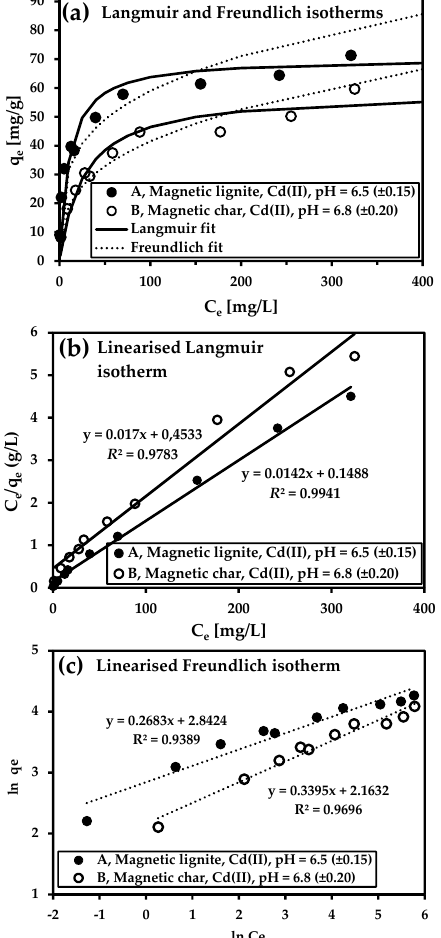
Figure 9. Langmuir and Freundlich adsorption isotherms for Cd(II) ( a ). The adsorption isotherms were calculated using the linearised forms of the Langmuir ( b ) and Freundlich ( c ) models. Conditions: samples, magnetic char and magnetic lignite; batch-type system; sorbent concentration, 2 g / L; initial metal concentration, 10–464 mg / L; room temperature; 24